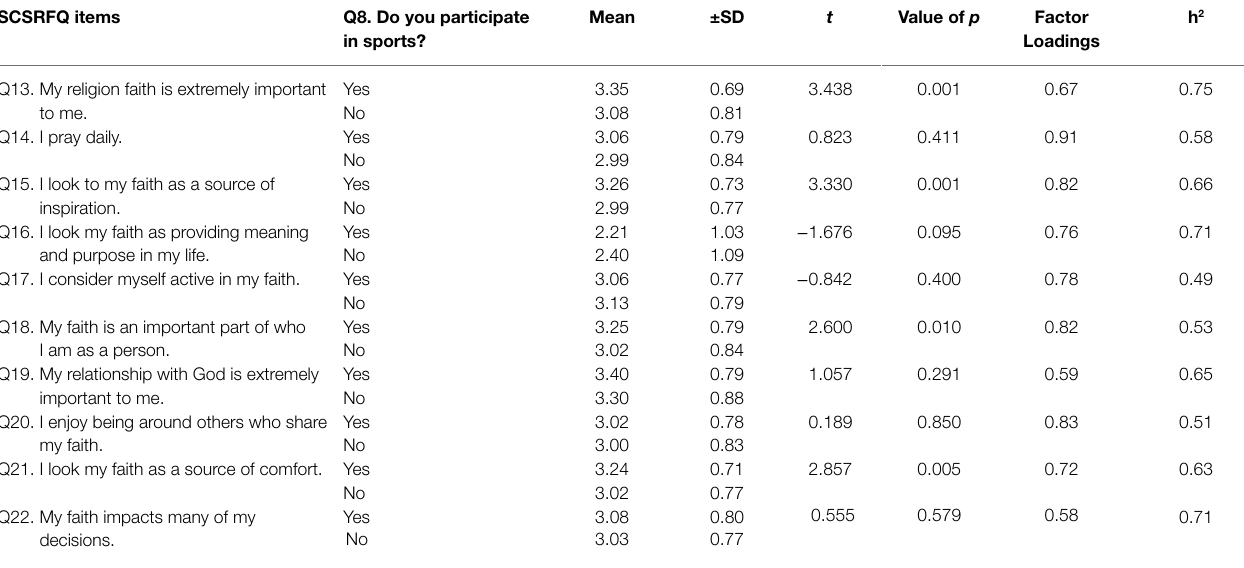
TABLE 2 | SCSRFQ items t -tests: Differences between sports participating and non-participating women with factor loadings and h 2 . SCSRFQ